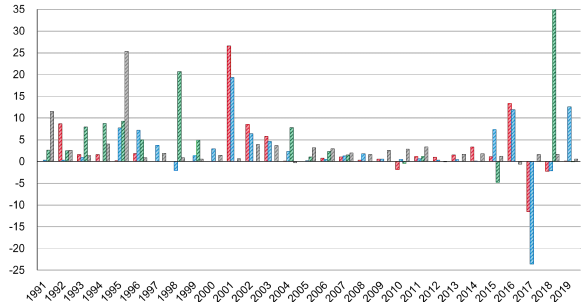
Figure 2 . Land area of built-up area-urban non-agricultural permanent population growth elasticity coefficient.